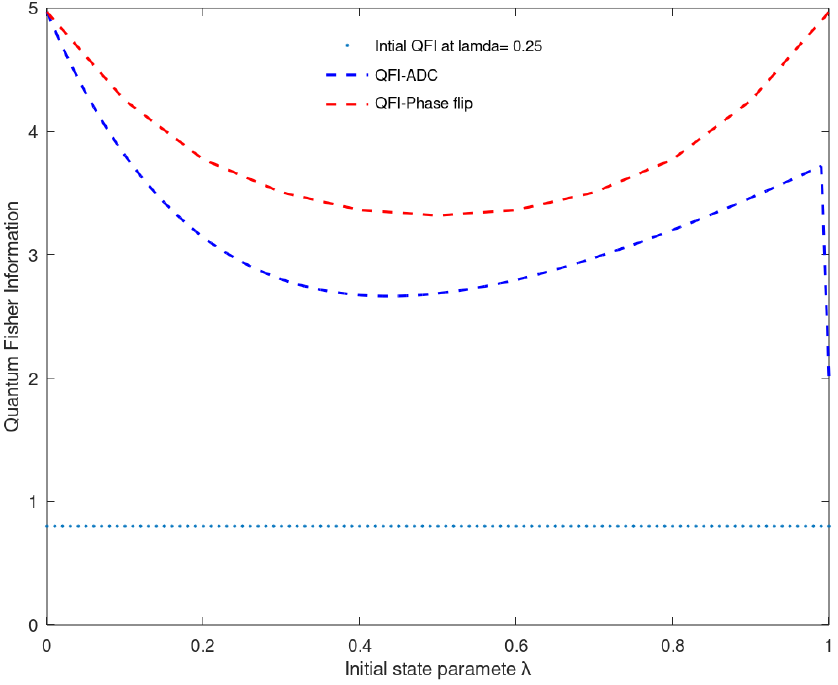
Figure 6. Average QFI attained by Bob’s final states with respect to the noise parameter a , when the channel shared between the two parties taken as the 4-qubit W state is inflicted with amplitude damping noise (blue dashed line), and phase flip noise (red dashed line). In this example, the initial state parameter is taken to be 0.25, and Alice measures her register in basis B 2